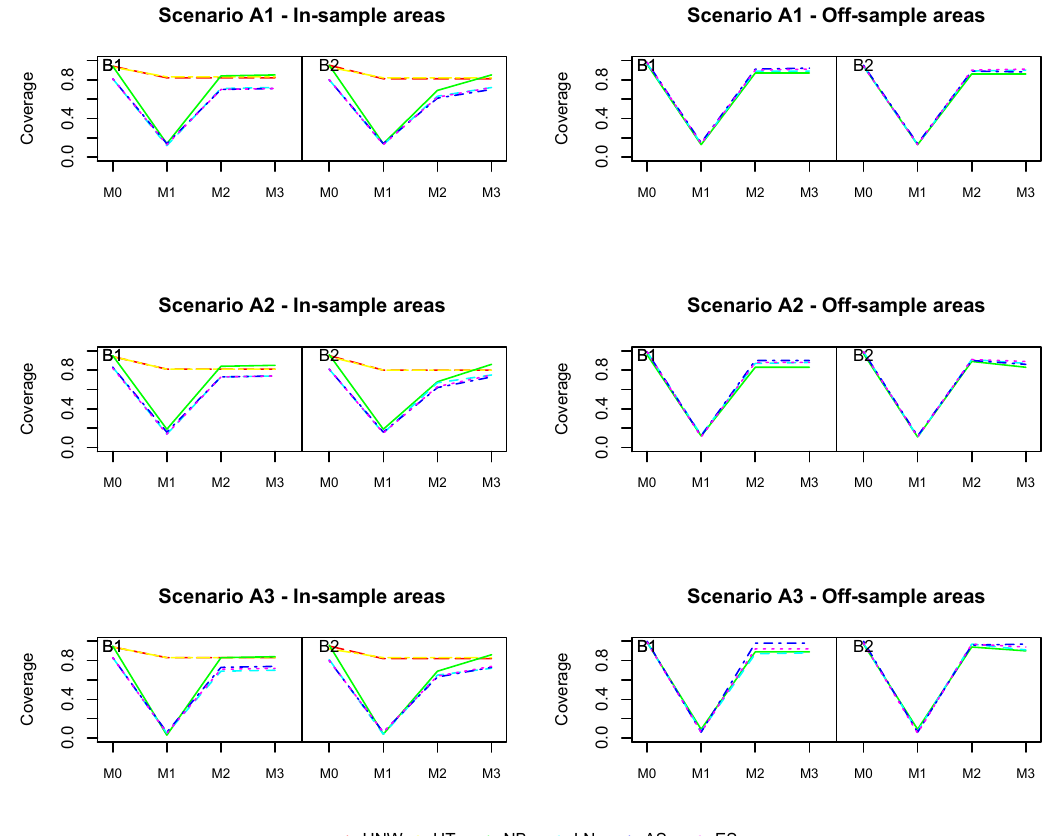
Figure 8. Simulation 2: Coverage probabilities. UNW = unweighted estimator; HT = Horvitz– Thompson estimator; NB = naive binomial model; LN = logit-normal model; AS = arcsine model; ES = effective sample size model. ( A 1 ) : σ 2 v = 0.15 and σ 2 u = 0.03; ( A 2 ) : σ 2 v = 0.09 and σ 2 u = 0.09; ( A 3 )